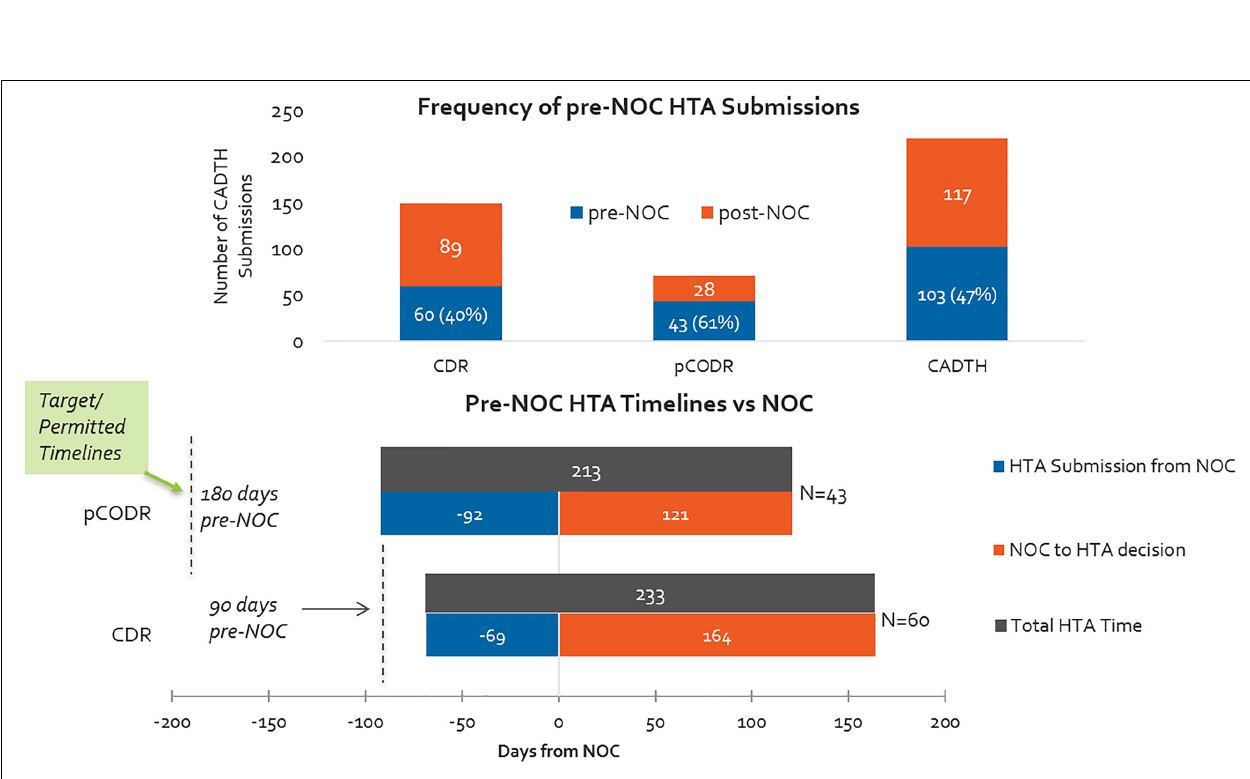
FIGURE 9 | (Top) Percentage of HTA submissions submitted pre- and post-NOC, 2012–2016 (CADTH only). (Bottom) HTA submission timelines with respect to target/permissible timelines for pre-NOC filing, pCODR vs. CDR.